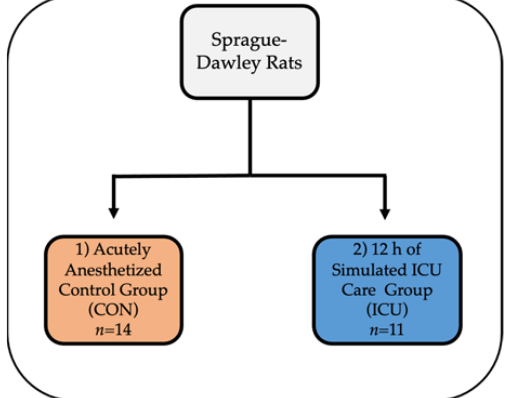
Figure 1. Experimental design. Two groups. (1) Acutely anesthetized control group (CON, n = 14). N = 14. (2) 12 h of simulated ICU care group (ICU, n =11). No differences in body weight existed between the two groups at the start of the experiment (CON = 291 g ± 7.2; ICU = 286 g ± 3.2). CON animals remained awake and ambulatory in their cages throughout the 12 h experimental time period. At the endpoint, CON animals were acutely anesthetized using intraperitoneal (IP) injections with sodium pentobarbital (60 mg/kg body weight). Upon reaching a surgical plane of anesthesia, the animals received an IP injection of puromycin (0.04 μ mol/g of body weight) (InvivoGen, San Diego, CA, USA) for the measurement of protein synthesis [13]. The incorporation of puromycin into growing polypeptide chains (i.e., protein synthesis rate) was later deter ‐ mined by immunoblotting for puromycin in the total protein extracts via Western blotting. Thirty minutes following the injection of puromycin, the animals were euthanized, and the soleus, plantaris, parasternal intercostal, and intercostal (intact external and internal intercostal) muscles were promptly removed. Tissues were rapidly frozen in liquid nitro ‐ gen and stored at − 80 °C for subsequent biochemical analysis. A section from each muscle was rapidly frozen in an OCT medium at an unstressed length in isopentane and was chilled to the temperature of liquid nitrogen. These samples were then stored at − 80 °C for the subsequent measurement of the muscle fiber cross ‐ sectional area (CSA). Animals in the ICU group were anesthetized using IP injections with sodium pentobarbital (60 mg/kg body weight) and underwent 12 h of controlled MV. Throughout the 12 h MV pe ‐ riod, the animals remained immobile with their limbs passively stretched every two hours. Animals received puromycin (0.04 μ mol/g of body weight) identical to the CON group thirty minutes prior to the end of the 12 h experimental period and were euthanized thirty minutes later. Tissues were then removed and stored identically in the CON group. 2.2. Simulated ICU Protocol All surgical procedures incorporated aseptic techniques. Briefly, the animals received an IP injection of sodium pentobarbital (60 mg/kg body weight). After reaching a surgical plane of anesthesia, animals underwent a tracheostomy and were mechanically ventilated for 12 h with a pressure ‐ controlled ventilator that provided the full work of breathing (Servo Ventilator 300; Siemens, Munich, Germany). Ventilator settings included a respir ‐ atory rate of 80/breaths per minute with the positive end ‐ expiratory pressure established at 1 cm H 2 O. Following the tracheostomy, the carotid artery and jugular vein were cannu ‐ lated for the measurement of arterial blood pressure and the continuous infusion of anes ‐ thesia (sodium pentobarbital, ~10 mg/kg/hr) during the experiments. Arterial blood sam ‐ ples were obtained periodically to monitor arterial blood gas values (PaCO 2 , PaO 2 , and pH) (GEM Premier3000; Instrumentation Laboratory, Lexington, MA, USA). Adjustments to the ventilator settings were performed to control alveolar ventilation and fraction of